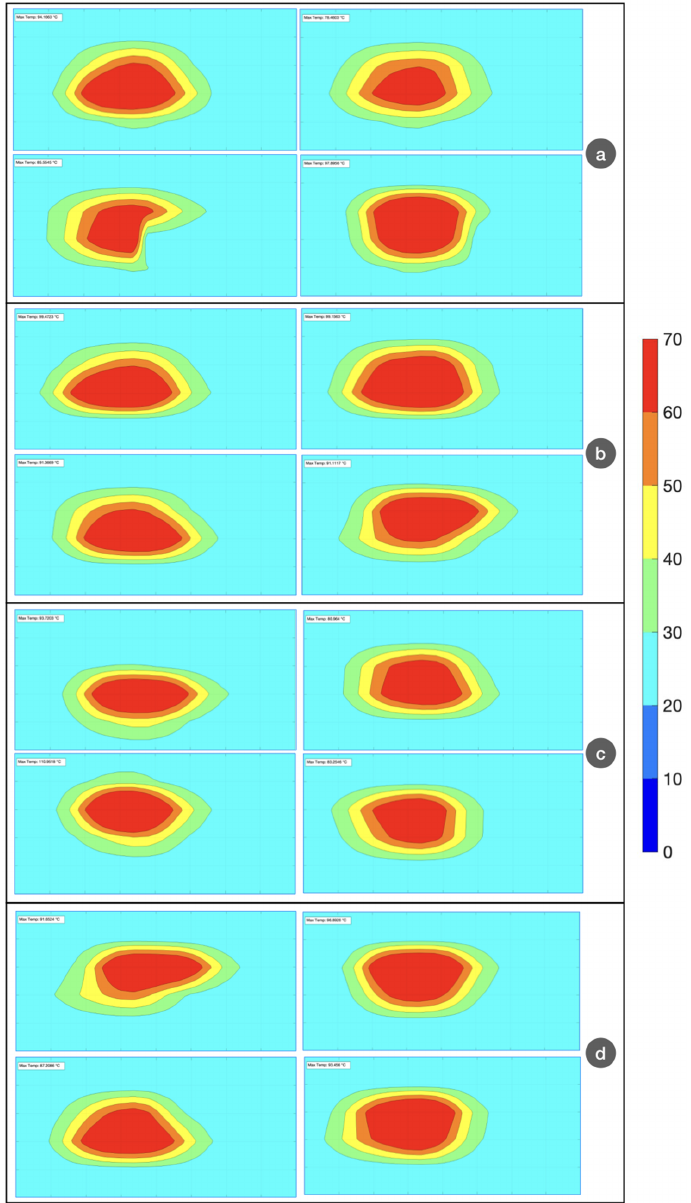
Figure 10. Evaluation of all thermal maps for four experiments, under each condition: ( a ) pristine; ( b ) agarose; ( c ) AuNP, 1 mg/mL; ( d ) AuNP, 4 mg/mL. The chart reports isothermal curves, according to the color bar on the right. Horizontal axis: x direction (4 cm range); vertical axis: y direction (2 cm range).